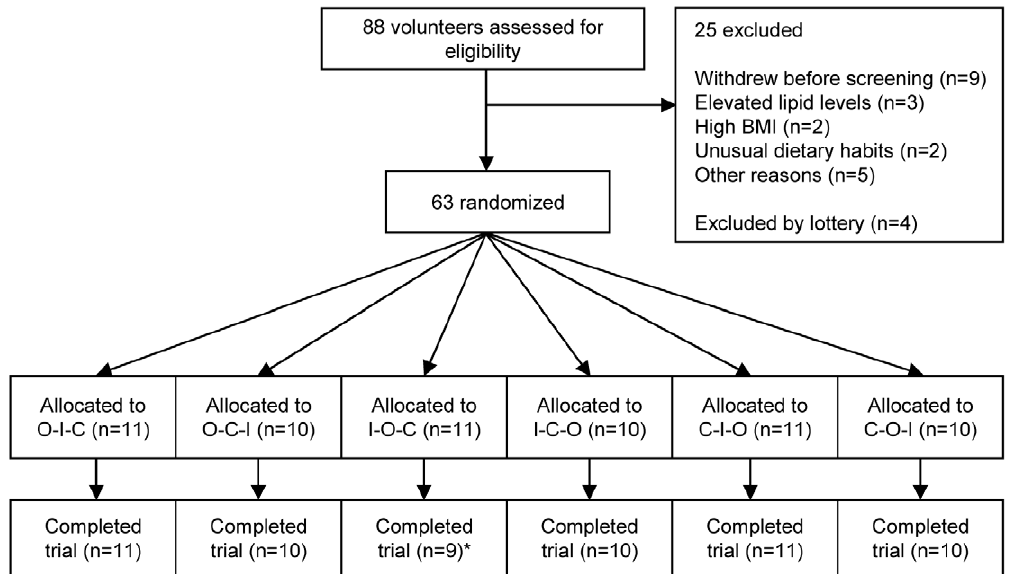
Figure 1. Flow chart of a randomized cross-over trial of the effect of Conjugated Linoleic Acid (CLA) on lipoprotein levels in 61 healthy subjects. Each intervention period lasted 3 weeks; O, Oleic acid diet; I, Industrial trans fat diet; C, CLA diet. * 2 subjects dropped out early in the study, one for personal reasons and one because of illness, both unrelated to the trial. These subjects were not included in the analysis.